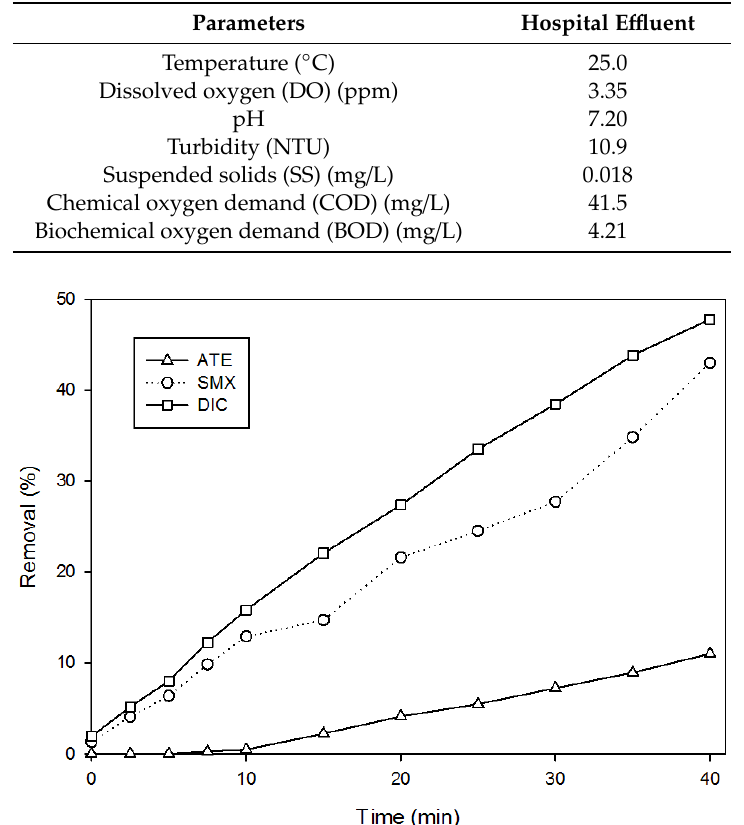
Figure 6. Removal efficiencies of spiked pharmaceuticals in actual hospital effluent matrices ([Phar.] s = 100 µM, [NaCl] = 0.01 M, I = 0.5